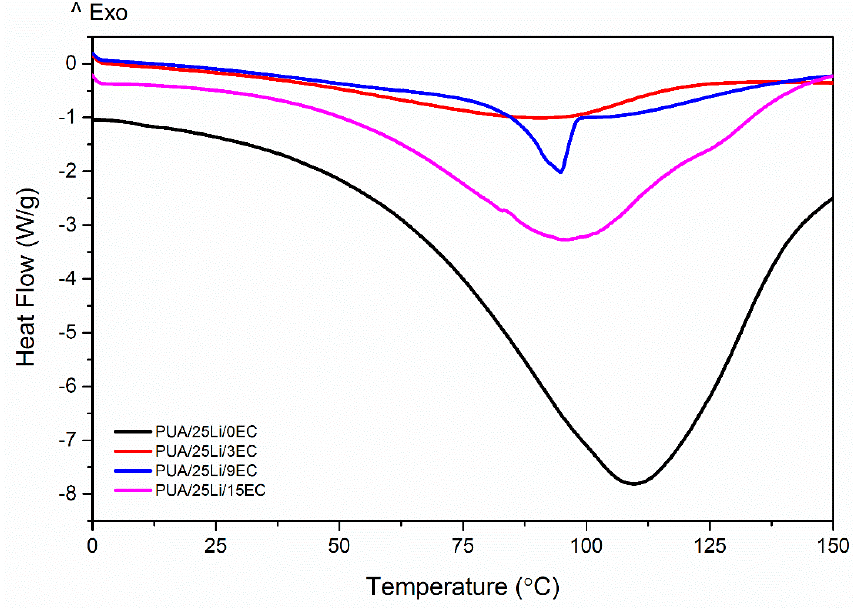
Figure 11. DSC thermograms PUA/LiClO 4 /EC electrolytes.